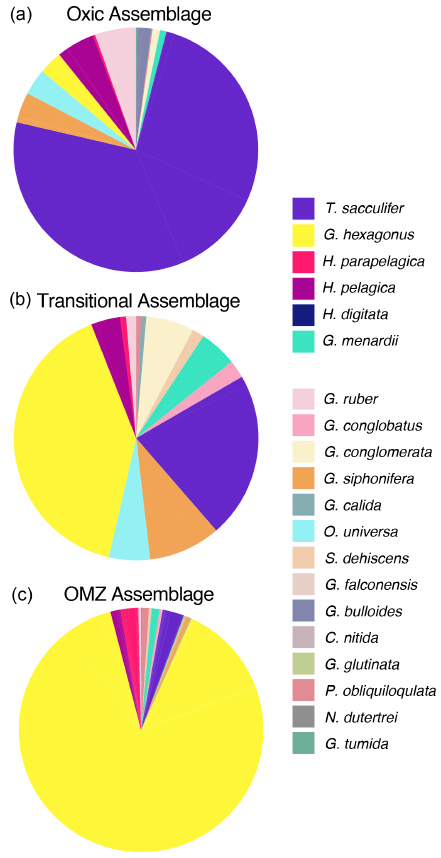
Figure 6. Pie plots of the live foraminiferal assemblages recov- ered from oxic nets (minimum dissolved oxygen > 2 . 45mLL − 1 ; a ), transitional nets (b) , and OMZ nets (maximum dissolved oxy- gen < 1.4mLL − 1 ; c ). Each color represents a different species (see